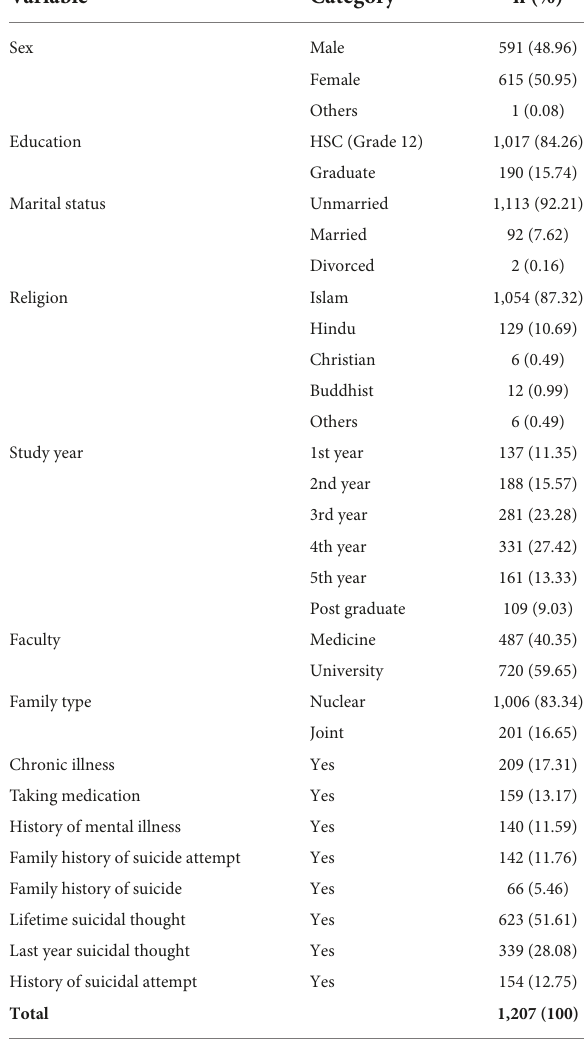
TABLE 1 Sociodemographic variables of participants ( n =